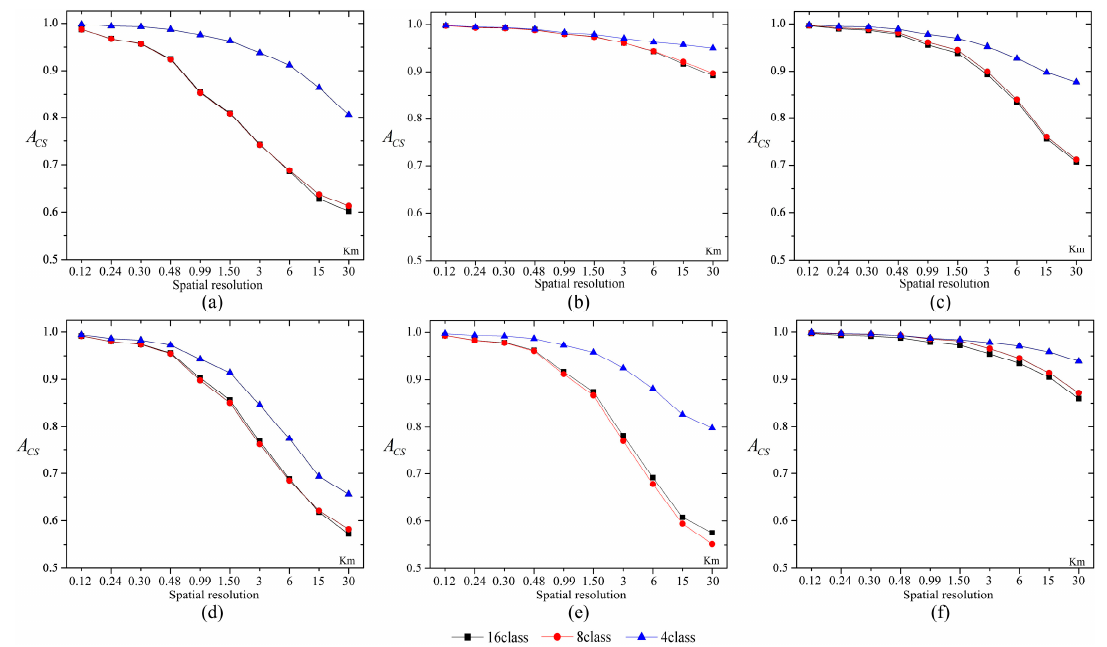
Figure 6. The A cs values during 2001–2006 with different land cover class schemes. ( a – f ) Represent the results of the study areas A to F, respectively.